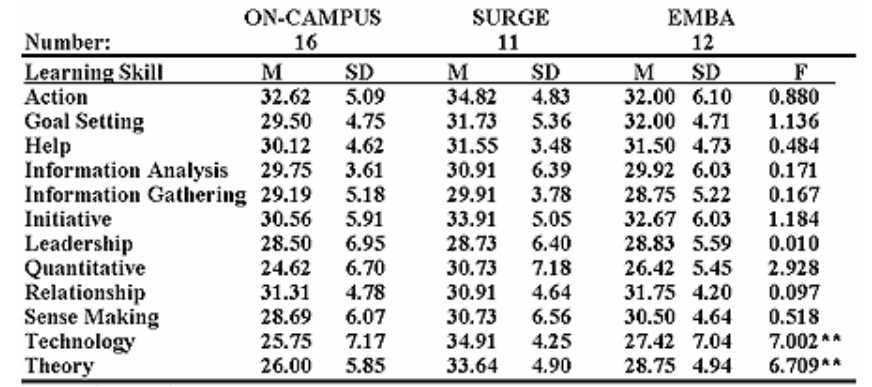
Table 4. Analysis of variance of LSP learning skills by method (Exiting